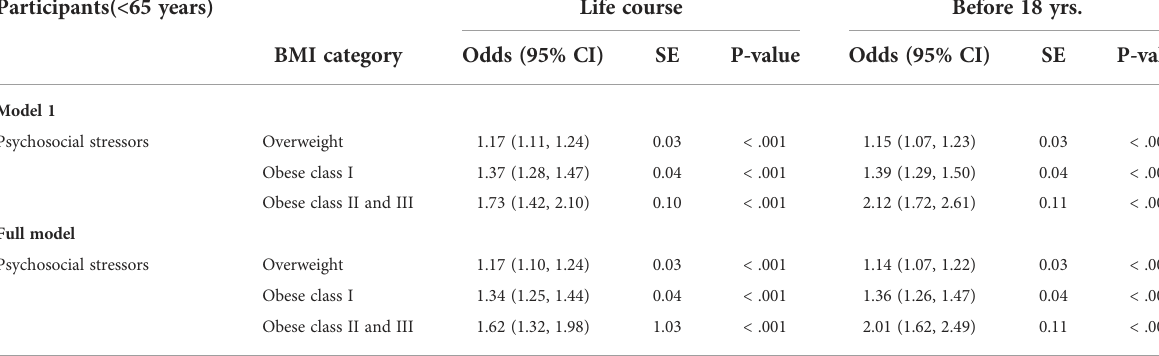
TABLE 2 Odds of BMI category considering psychosocial stressors over life course and in childhood/adolescence* adjusted for symptoms of anxiety and depression combined (adults). Participants(<65 years)